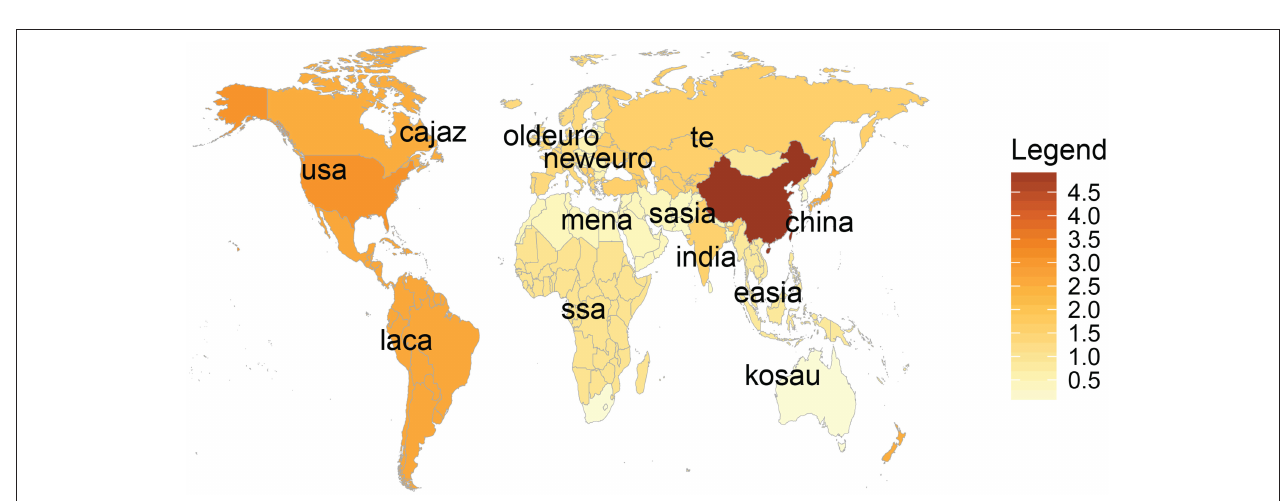
FIGURE 6 | Cumulative leaked emissions by 2100 in the scenario 550, NN and leakage rate of 0.1 % / year [ GtCO 2